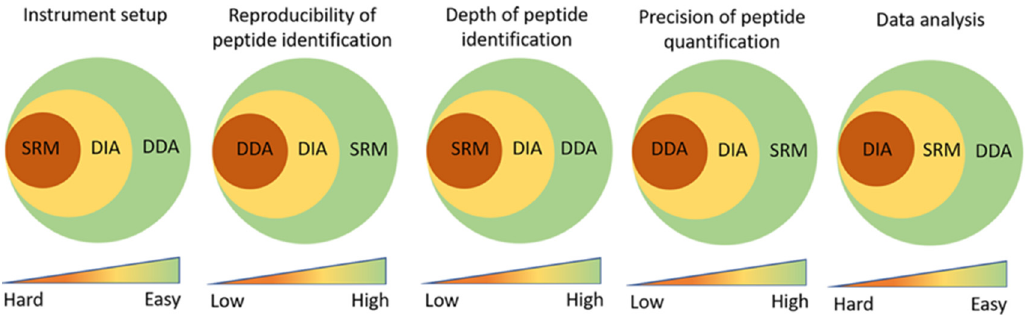
Figure 1. Advantages and limitations of MS-based proteomics using either data-dependent acquisition (DDA), data-independent acquisition (DIA), or the targeted approach called selected reaction monitoring (SRM). SRM requires prior identification of peptides and therefore currently has the hardest instrument setup, while DDA offers the easiest and is the default mode of use on most mass spectrometers. On the other hand, SRM offers the highest reproducibility and is the most sensitive method regarding peptide quantification because of a high signal-to-noise ratio. DIA is almost comparable to SRM with respect to the reproducibility and precision of quantification but is more vulnerable to variation caused by interference from other peptides. While DDA shows the least optimal performance regarding the reproducibility and precision of peptide identification and quantification, it is currently the method of choice for most discovery proteomics studies due to the high depth of peptide identification and easy data analysis.